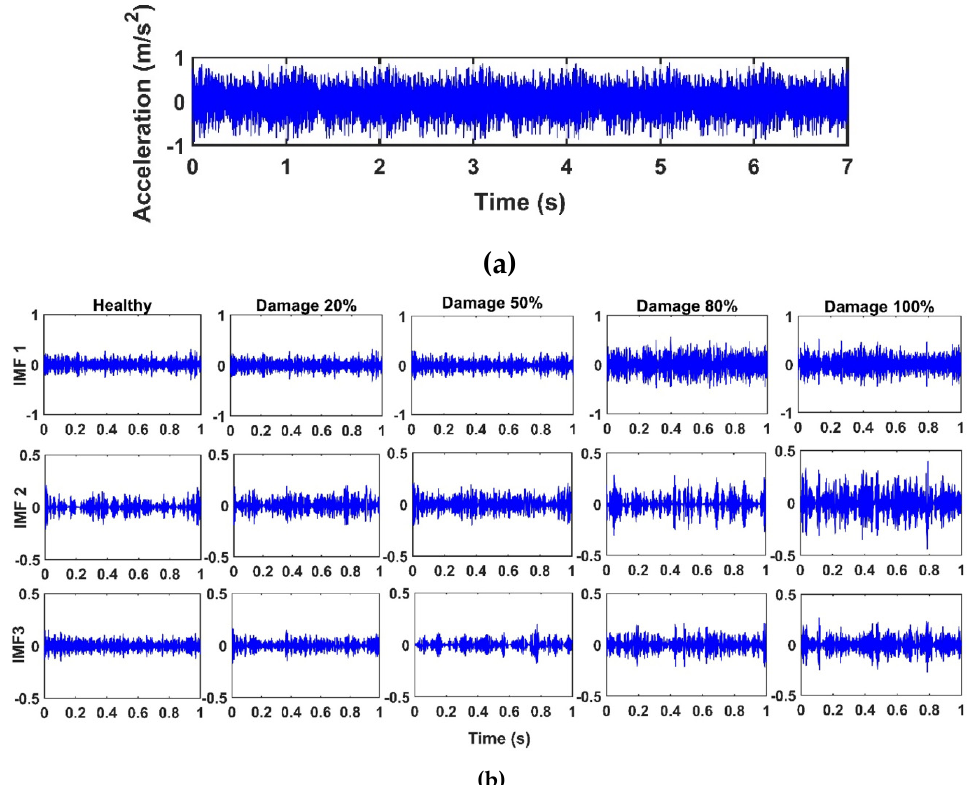
Figure 6. ( a ) acceleration response of sensor-10 for a healthy state of the bridge; ( b ) the first three intrinsic mode functions (IMFs) extracted by the CEEMDAN for sensor-10 for the healthy state and different damage levels.